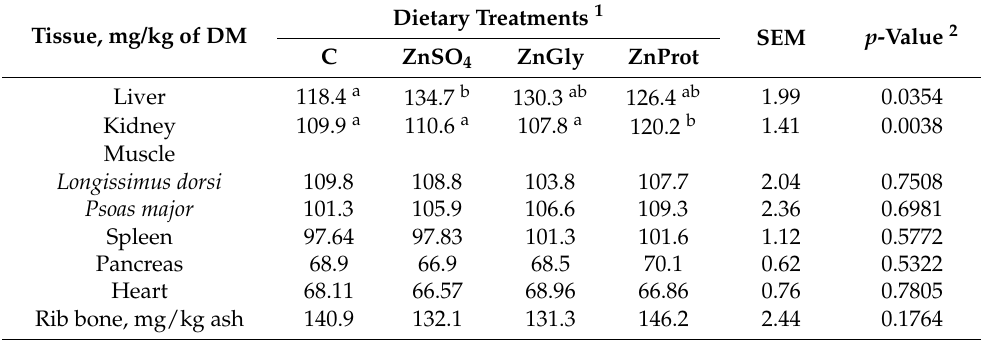
Table 4. Tissue Zn concentrations in lambs fed diets differing in Zn source (80 mg Mn/kg) for the 120 day feeding